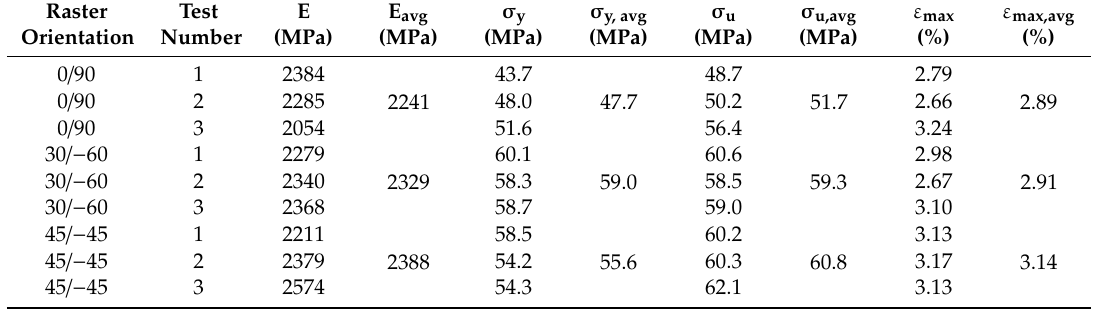
Table 1. Tensile results for every sample tested. E: Young’s modulus; σ y : yield stress; σ u : ultimate tensile strength; ε max : strain under maximum load; avg. subscript refers to average values. Raster